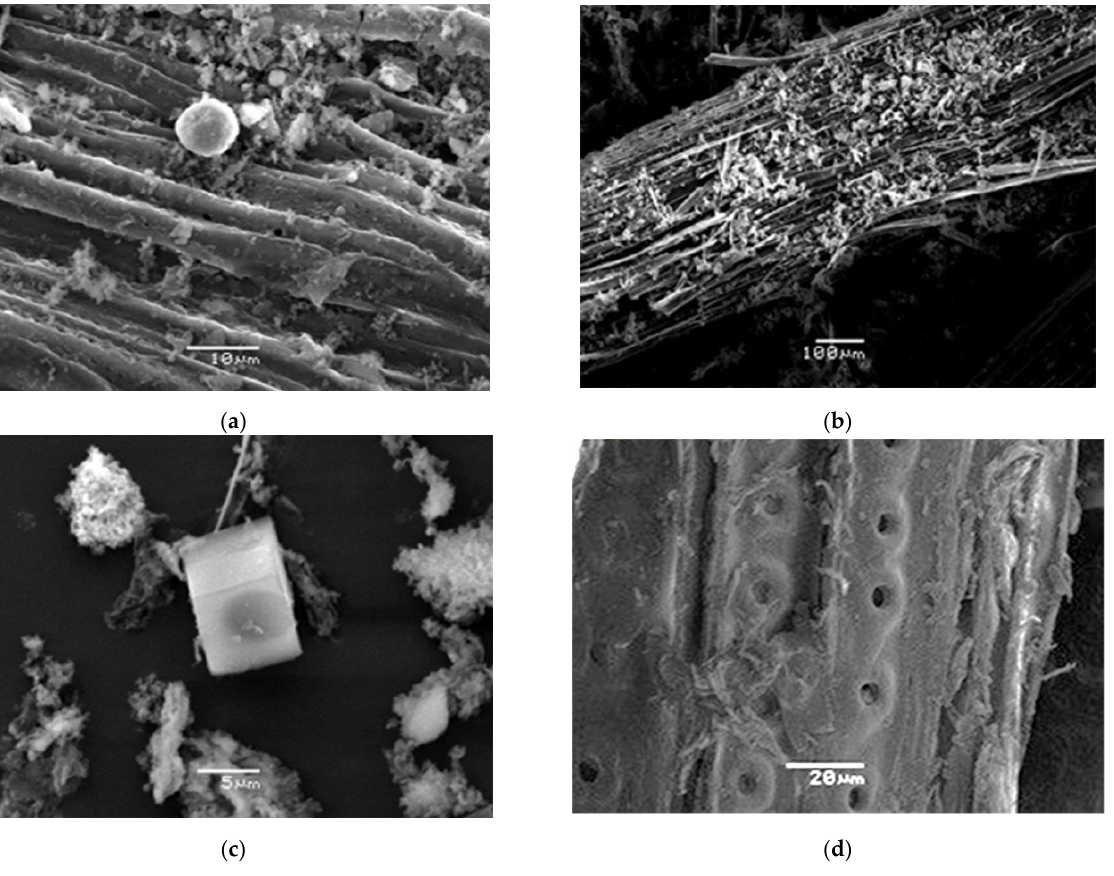
Figure 2. SEM micro-photographs of the biomass samples: ( a ) remaining structure along with a cenosphere in the olive kernel residual biomass ash, ( b ) unburnt porous carbon in the sawdust biomass ash, ( c ) newly formed euhedral calcite crystal in sawdust biomass ash, ( d ) porous structures of sawdust biomass.